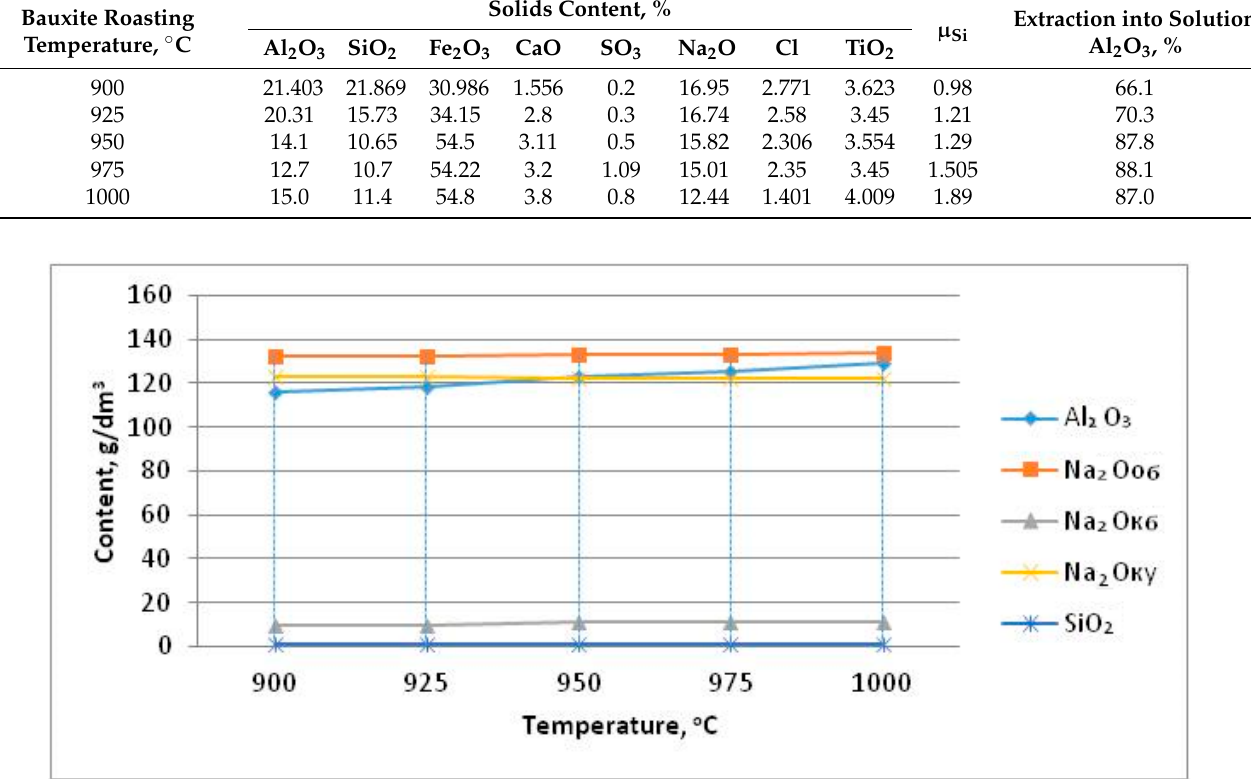
Figure 11. The compositions of aluminate solutions. Table 3. The compositions of solid phases (red mud) with μ Si and Al 2 O 3 extraction.